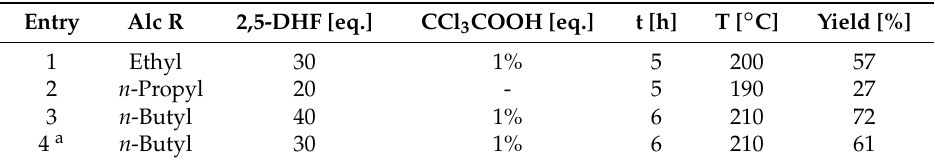
Table 4. Reaction conditions for the D IELS -A LDER reaction.